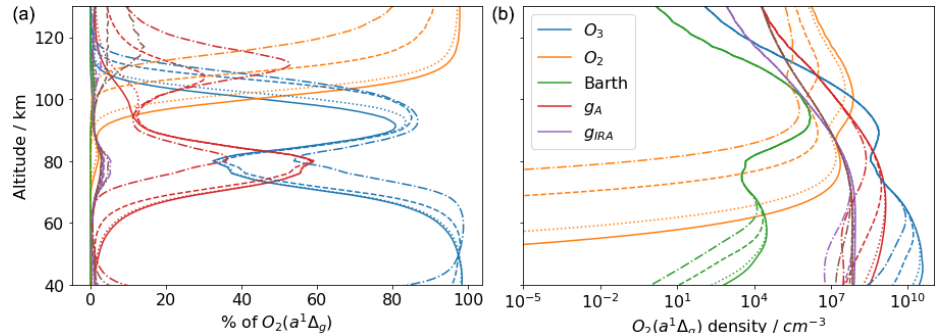
Figure 6. (a) Relative contributions of six different sources to the production rate of O 2 (a 1 (cid:49) g ) at four solar zenith angles, namely 30 ◦ (solid lines), 60 ◦ (dotted lines), 85 ◦ (dashed lines) and 89.9 ◦ (dotted–dashed lines). (b) The same as (a) but in absolute concentration of O 2 (a 1 (cid:49) g )